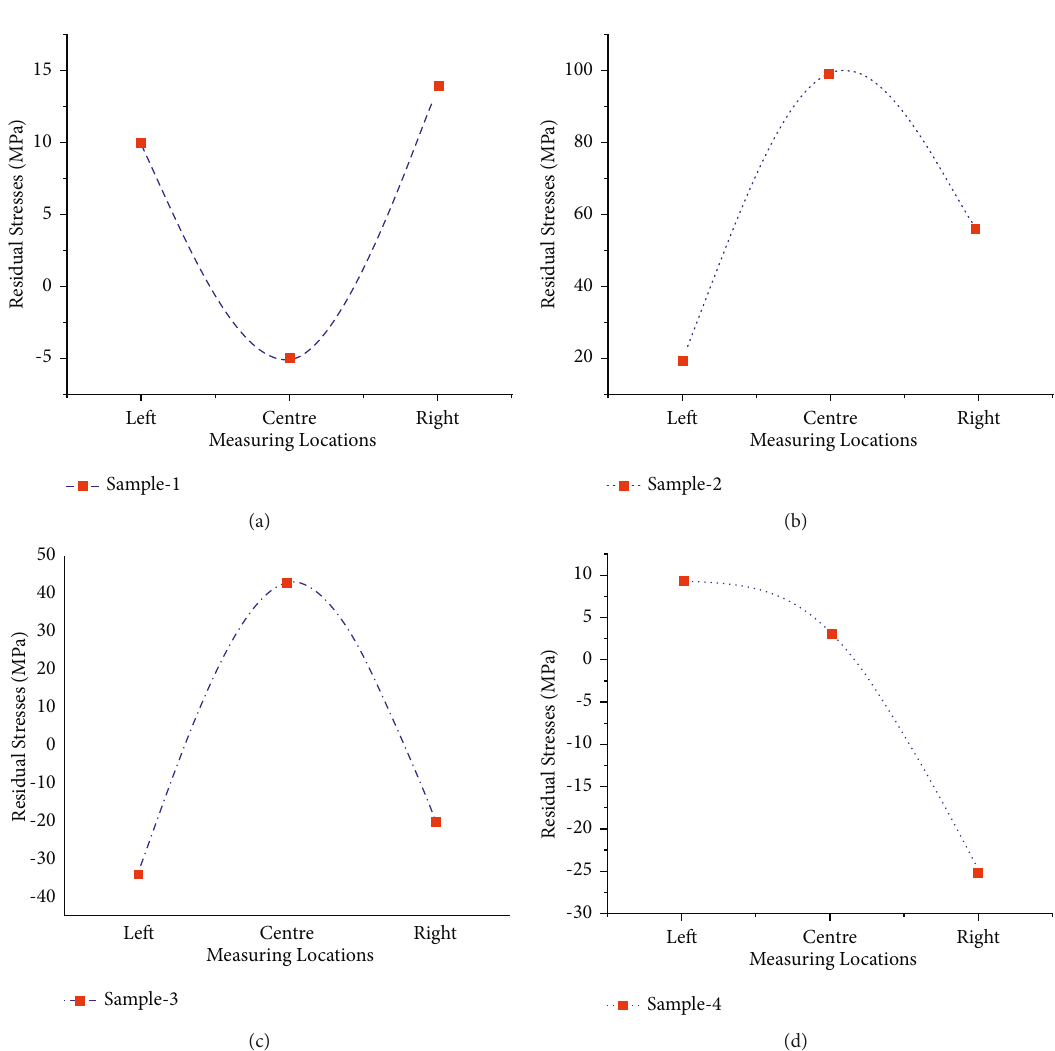
Figure 7: Residual stress distribution as a function of scanning strategy: (a) antiparallel horizontal, (b) chess field, (c) unidirectional, and (d)